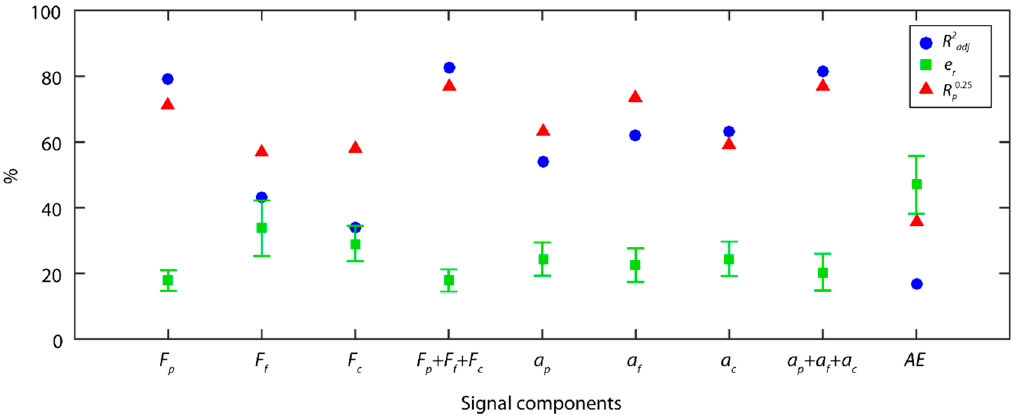
Figure 4. Signal analysis results with the TDA method.